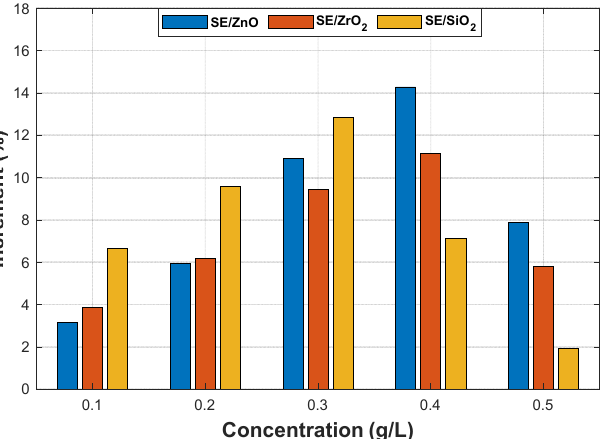
Figure 10. Comparison between the improvements of breakdown voltages of different nanofluids for different concentrations.